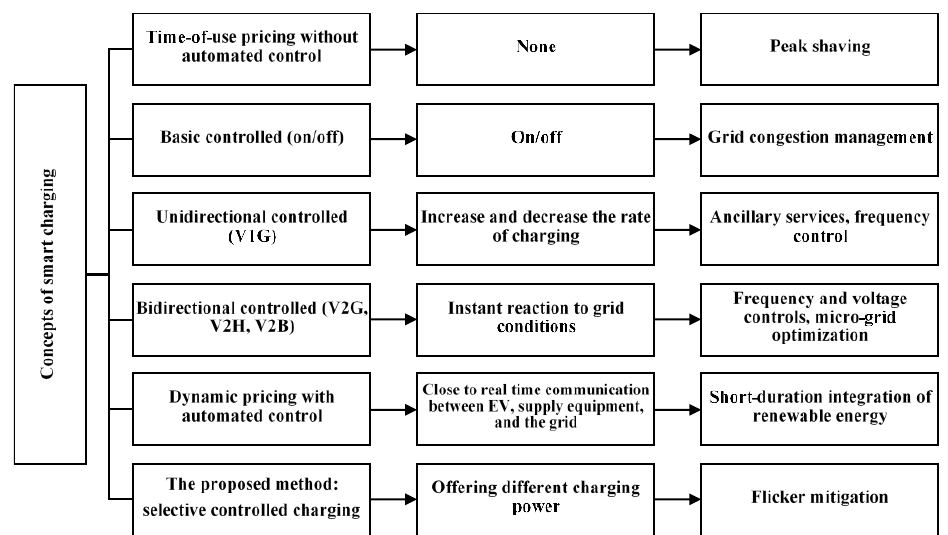
Figure 2. Comparison of smart charging and services provided to the grid [24].